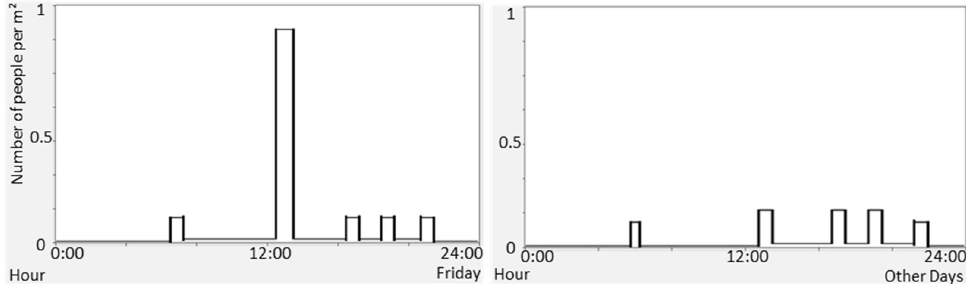
Figure 4. The usage density schedules on Friday and other days (except for Friday) of the base scenario.